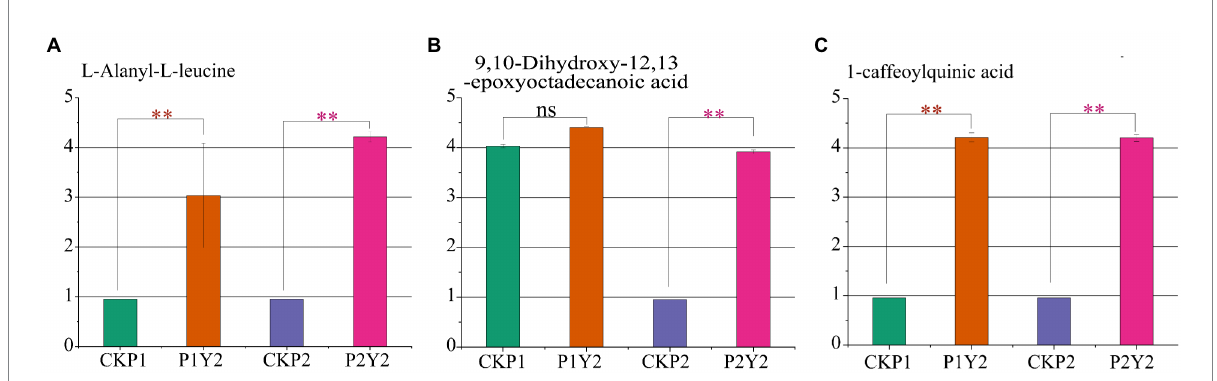
FIGURE 5 Differences in the relative contents of three nutrient markers in black mung bean variety (P1) and green mung bean variety (P2). L-Alanyl-L-leucine (A) , 9,10-Dihydroxy-12,13-epoxyoctadecanoic acid (B) , 1-caffeoylquinic acid (C) . Logarithmic (log10) transformation of the peak area matrix was performed to reduce the effect of concentration on pattern recognition. “**” means significant ( p < 0.05), “ns” means not